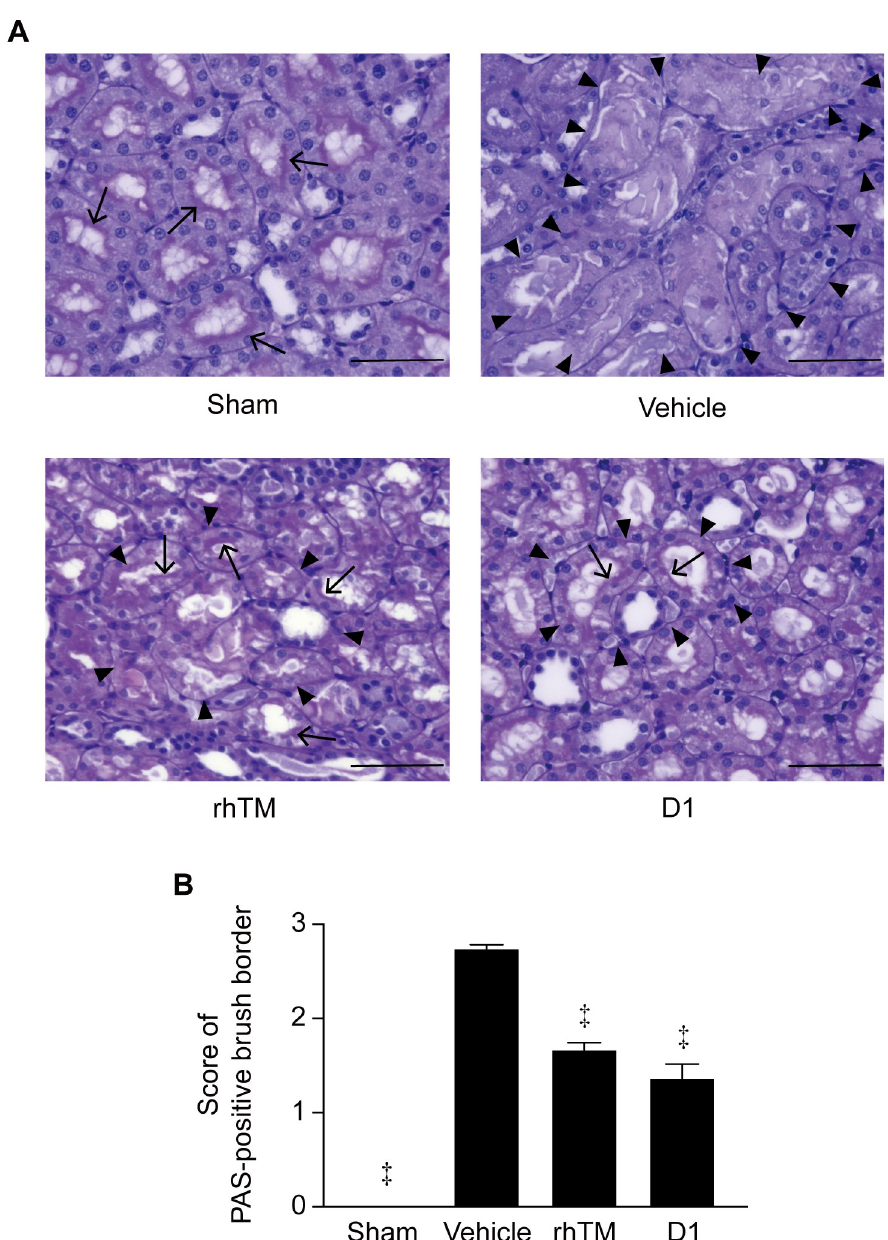
Fig 6. Histopathologiccal examination of kidney stained with PAS. A) Histologic findings in rat kidney. Renal tissue was obtained 16 h after CLP and stained with PAS. Arrowheads indicate degenerated areas and arrows indicate the PAS-positive brush border. Representative images are shown at a magnification of × 400. B) The score of the PAS- positive brush border in the four groups is shown (score of PAS = positive brush border). n = 6 per group. ‡ P � 0.001 vs. vehicle. Scale bars = 100 μ